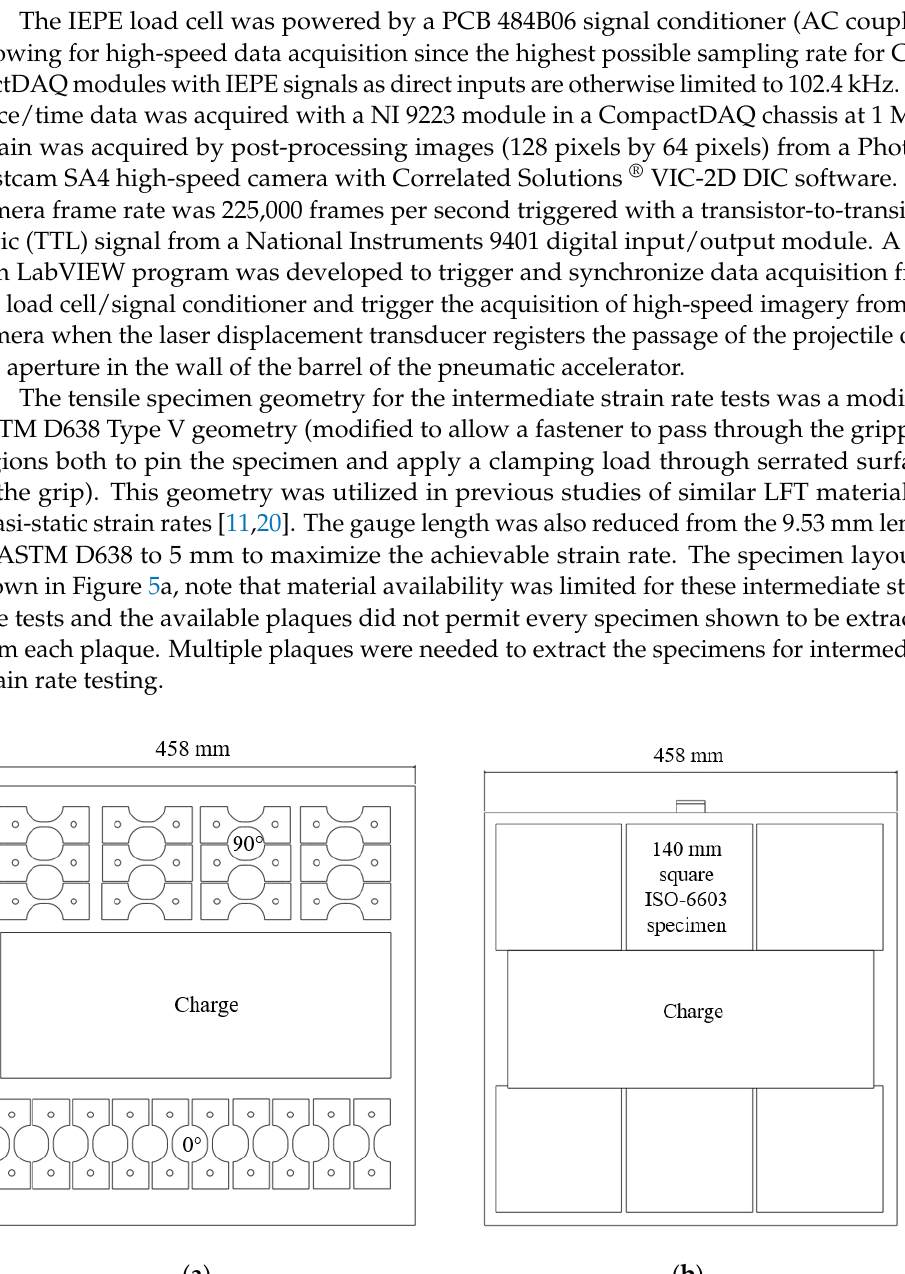
Figure 4. Focused view of the intermediate strain rate tensile apparatus.